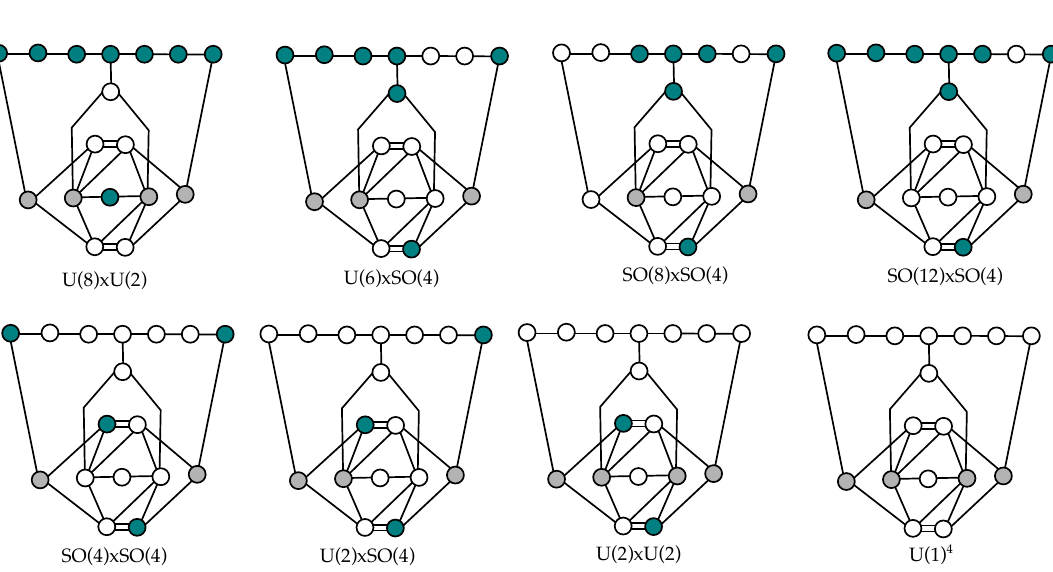
Figure 20. At the top we show the CFD for the marginal theory SU(2 n ) + 2 AS + 8 F , and below, using the notation of section 4 the possible embeddings of the BG-CFDs into the marginal CFD. Below the diagrams we note the classical (cid:13)avor symmetry of the corresponding weakly coupled